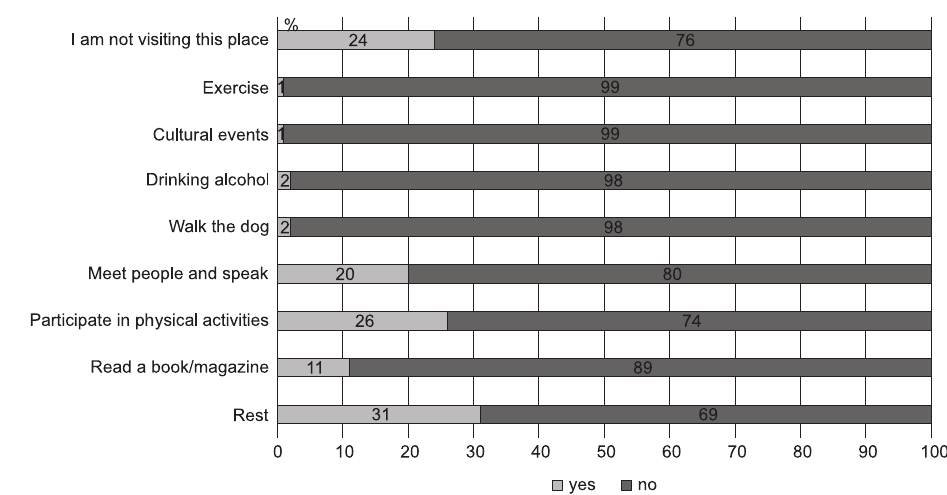
Fig. 5. The ways in which the respondents use Asnyk Square (%).